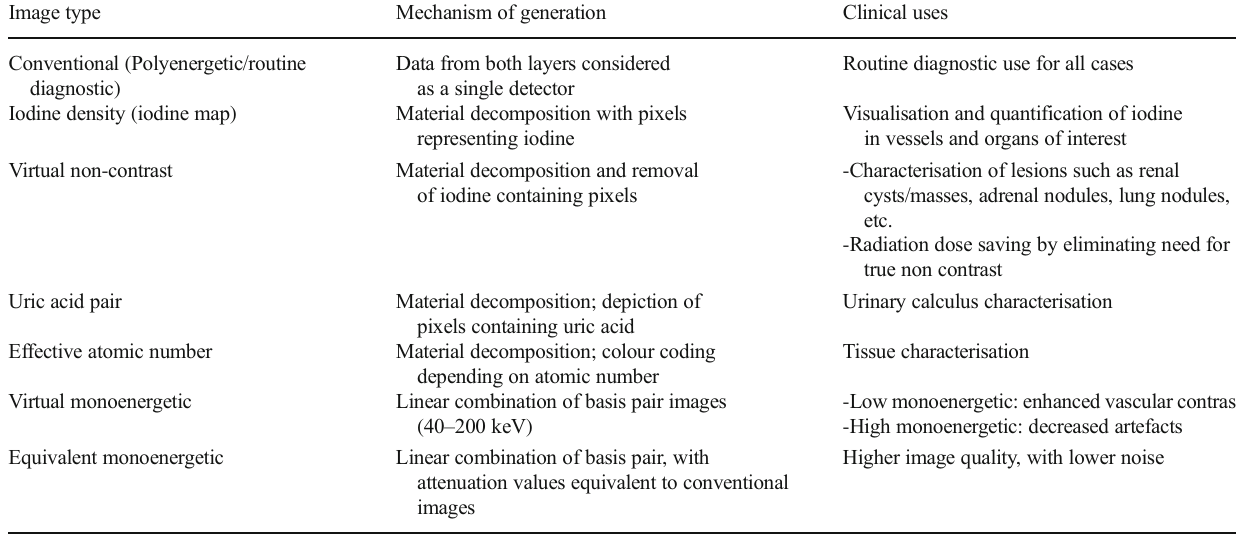
Types of images from the detector-based spectral CT scanner Image